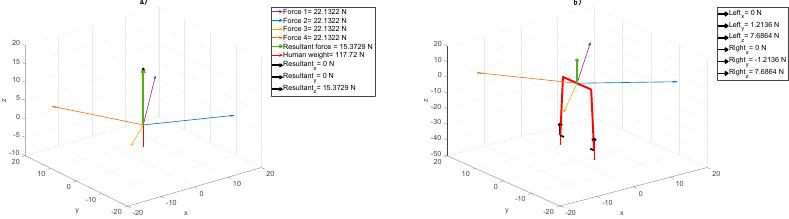
Figure 5. Elastic cord force values in SPIDER cage in case of human mass 12 kg and following set up: ( a ) cord elongations 1,2,3,4–100 mm; cord and COG level angle 1,2,3,4–10 deg, ( b ) elastic cord forces and foot reaction values in XYZ directions.